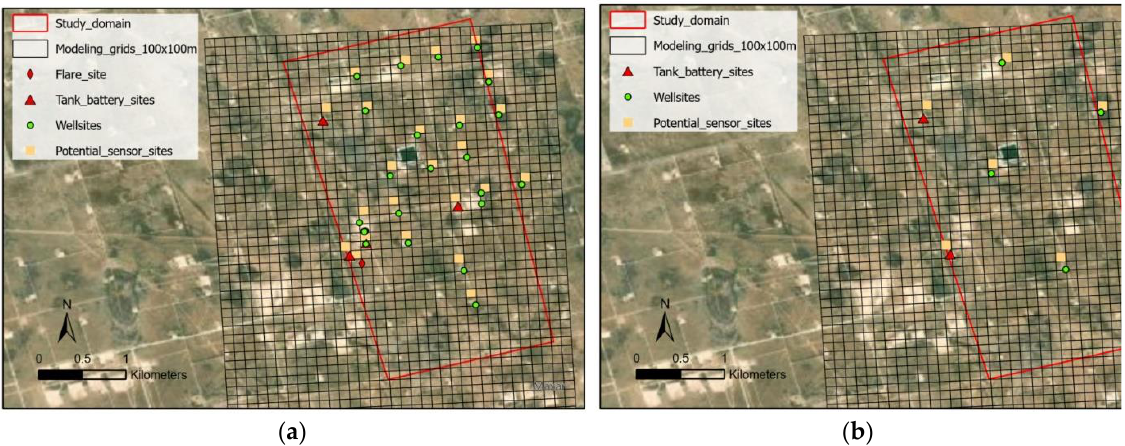
Figure 2. ( a ) Dispersion modeling base case domain and all sites and sensor locations in the domain. Emissions were sourced from well sites (dots) and tank batteries (triangles). ( b ) Dispersion modeling domain with reduced site density.